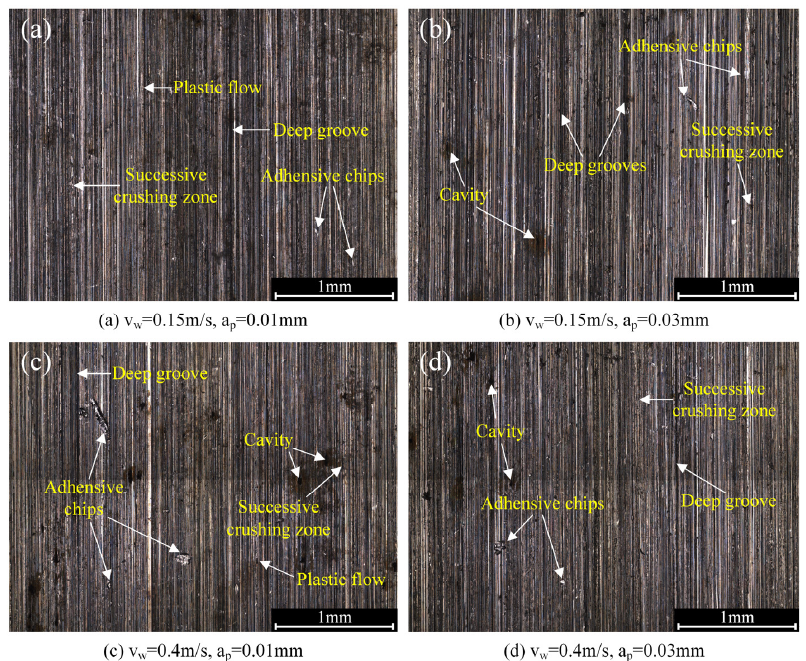
Figure 4. Tooth surface morphology after grinding with the parameter of ( a ) 0.15 m/s, 0.01 mm; ( b ) 0.15 m/s, ap = 0.03 mm; ( c ) 0.4 m/s, 0.01 mm; and ( d ) 0.4 m/s, 0.03 mm.